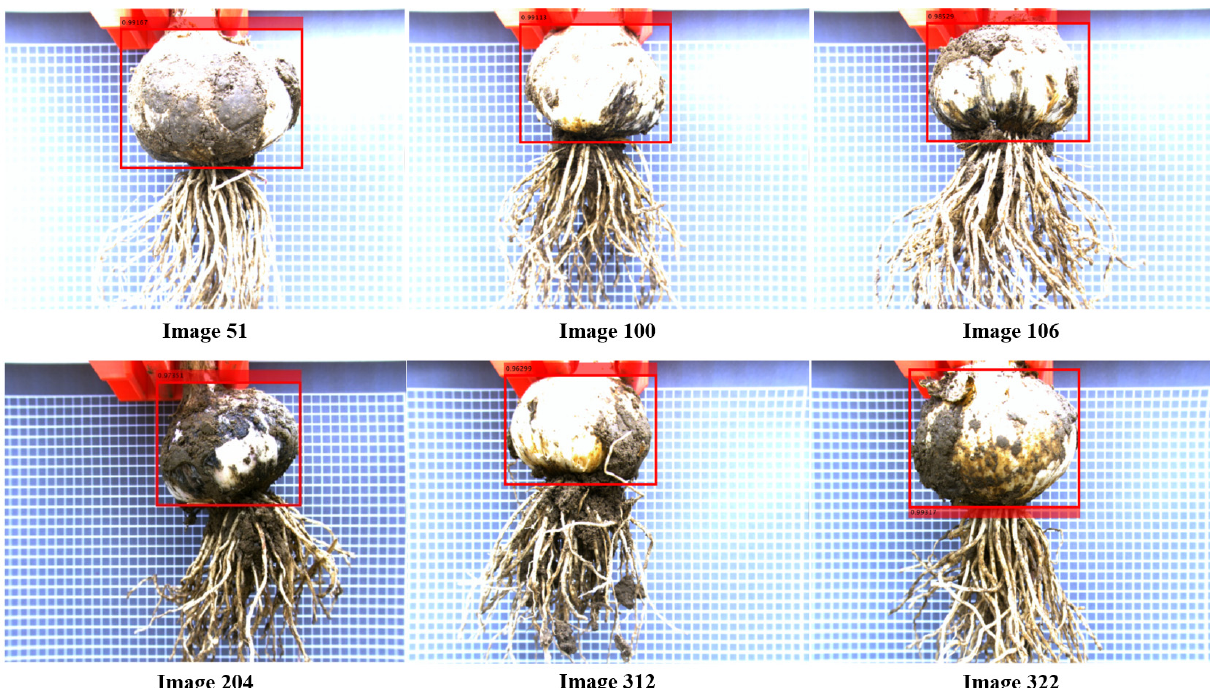
Figure 16. Cutting line position deviation predicted by different backbone networks.